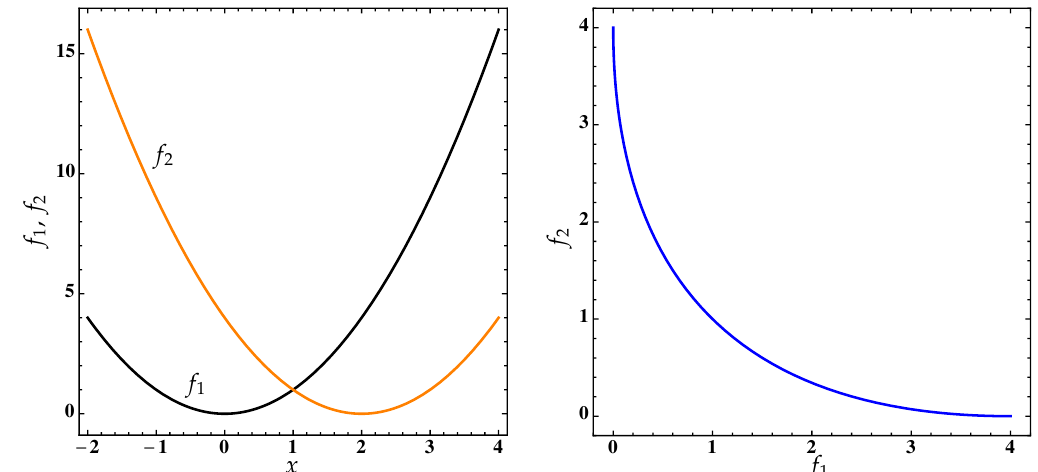
Figure 1. Left : the objectives f 1 ( x ) = x 2 and f 2 ( x ) = ( x − 2 ) 2 from a multi-objective optimization problem (MOP; Equation (1)). Right : the corresponding Pareto set over the interval [ 0,2 ]